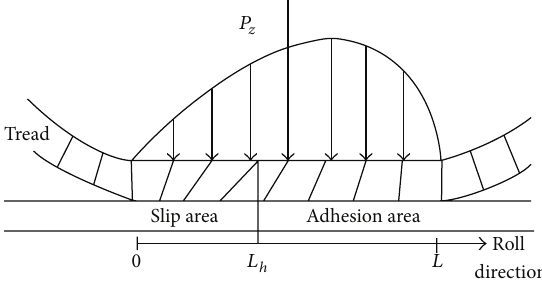
Figure 8: Tire contact patch distribution during tire